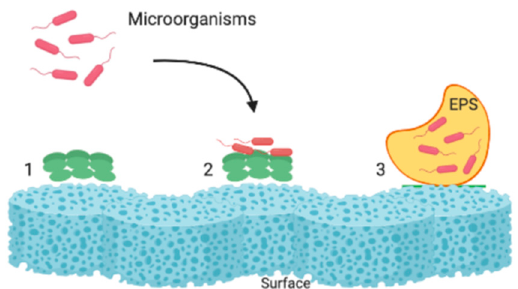
Figure 2. Steps of the biofilm formation: (1) Conditioning film (protein layer). (2) Transport to the surface and immobilization. (3) Attachment to the substrate [11].